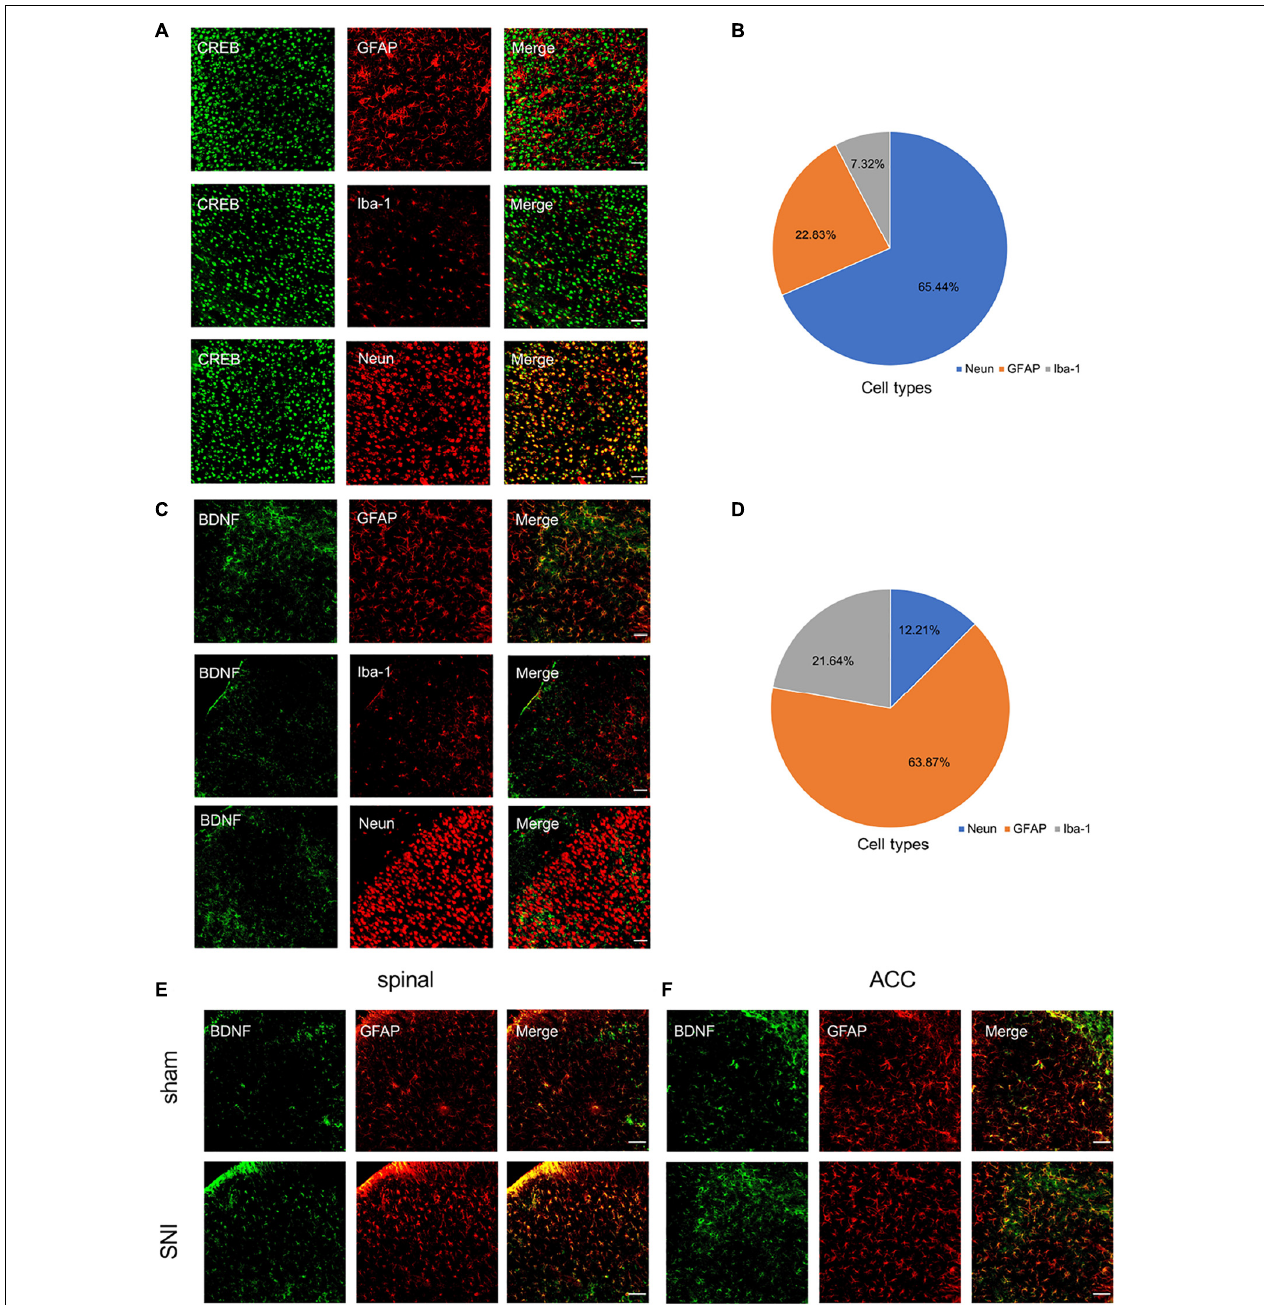
FIGURE 5 | Characterization of expression profile of CREB and BDNF in the ACC. (A,B) Representative examples (A) and quantitative summary (B) showing that CREB was highly coexpressed with neuronal nuclear antigen (NeuN), sparsely with either glial fibrillary acidic protein (GFAP) or Iba1 ( n = 3) (Scar bar = 50 µ m). (C,D) Representative examples (C) and quantitative summary (D) showing that BDNF was highly coexpressed with glial fibrillary acidic protein (GFAP), sparsely with either neuronal nuclear antigen (NeuN) or Iba1 ( n = 3) (Scar bar = 50 µ m). (E,F) Peripheral nerve injury increases the coexpression of BDNF and GFAP in the spinal cord (E) and ACC (F) (Scar bar = 50 µ